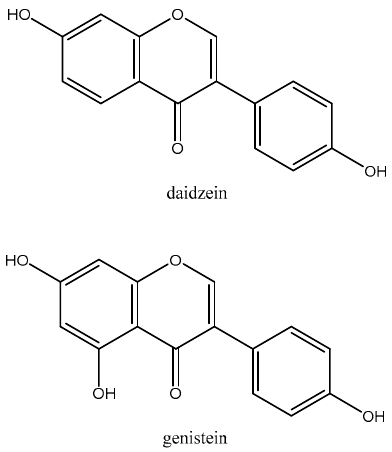
Figure 7. Chemical structures of daidzein and genistein.